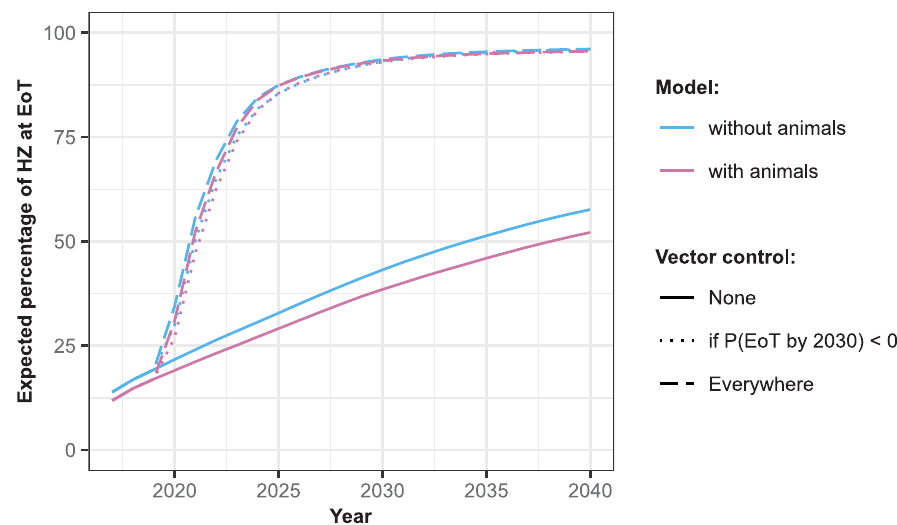
Fig 8. The percentage of health zones studied expected to have reached elimination of transmission (EoT) against year. Vector control (VC) was either simulated in none (solid lines), all (dashed lines), or a subset of health zones in which the probability of reaching EoT by 2030 without VC was less than 0.9 (dotted lines; using this cut-off measure, VC was simulated in 76% of health zones in the model without animal transmission and in 79% of health zones in the model with animal